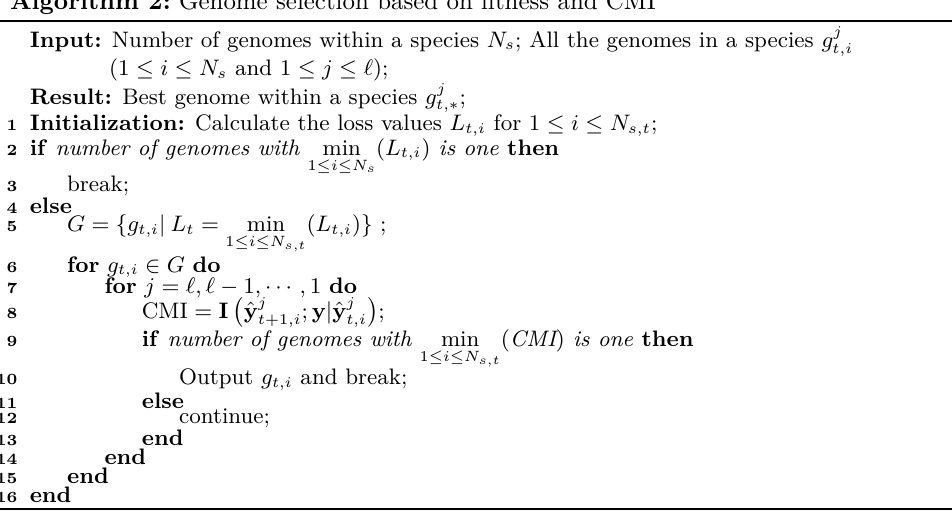
Algorithm 2: Genome selection based on fitness and